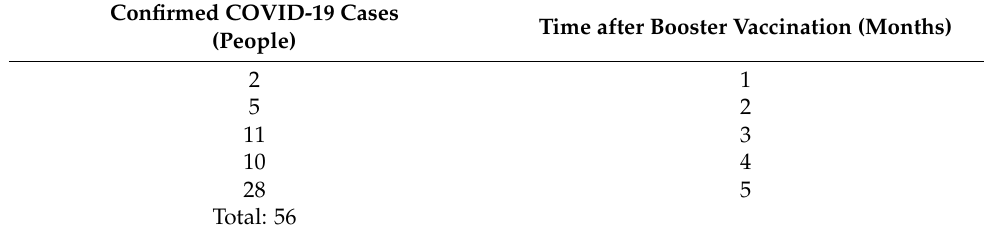
Table 3. Bivariate analysis of COVID-19 incidence within 5 months and the variables studied after mRNA-1273 booster